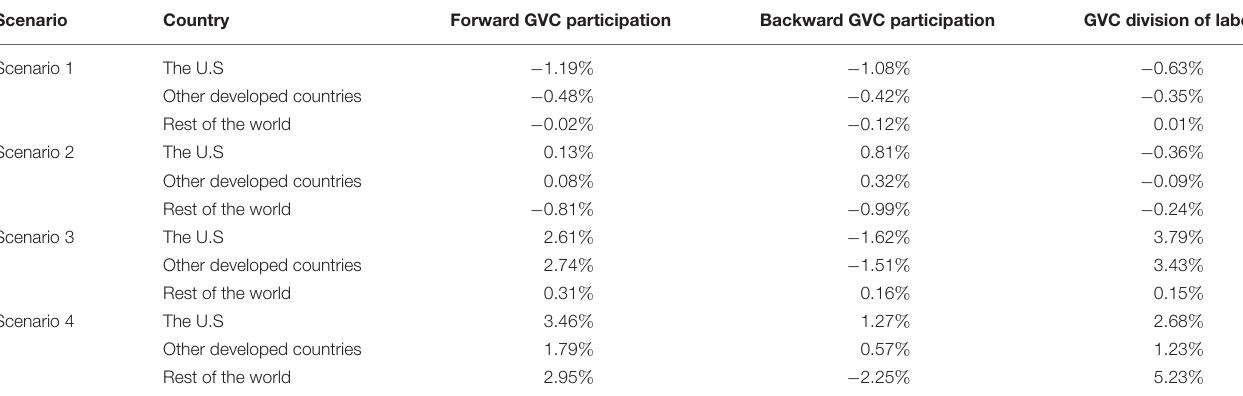
TABLE 3 | The impact of the pandemic on division of labor in GVC participation of China and its trade partners. Scenario Country Forward GVC participation Scenario